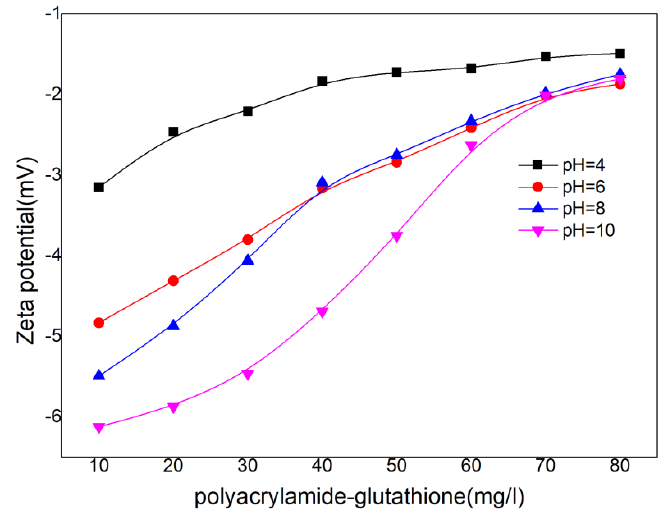
Figure 8. Zeta potential of polyacrylamide – glutathione